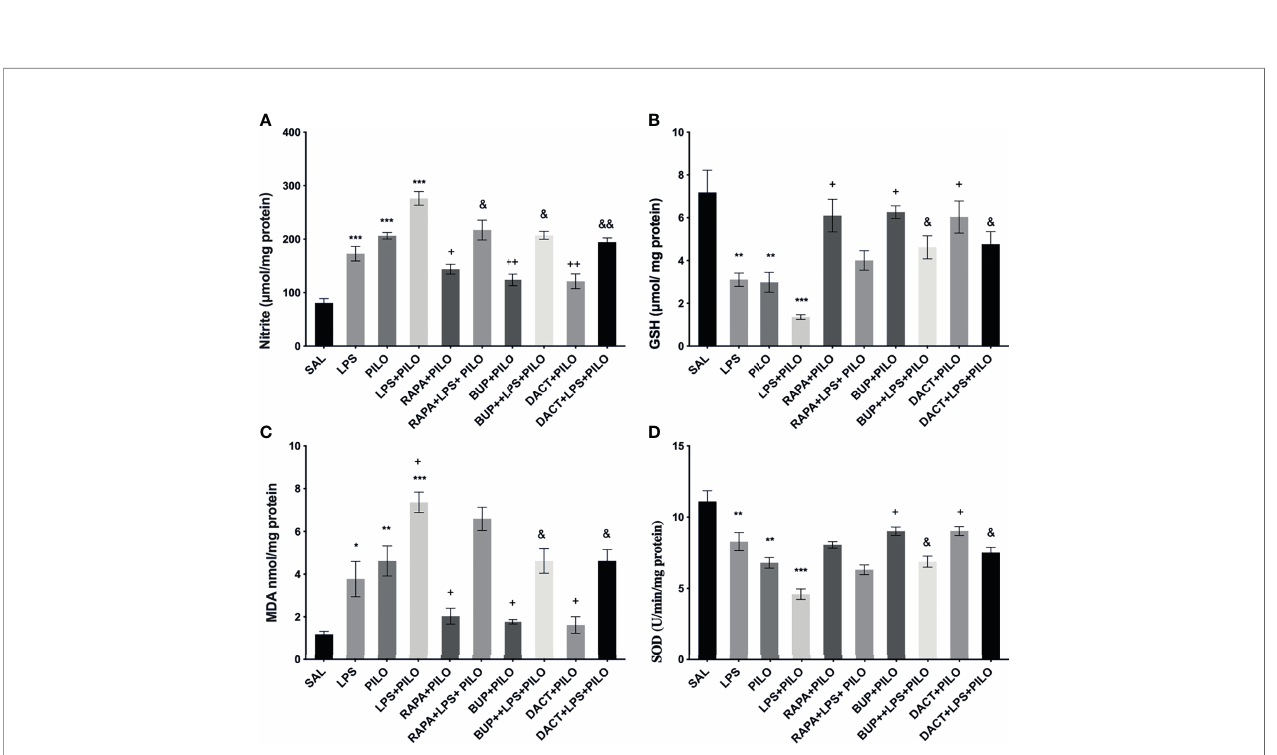
FIGURE 9 | Effects of RAPA, BUP, and DACT on PILO versus LPS+PILO-induced on oxidative stress levels in C57BL/6 mice. (A) Nitrite, (B) GSH, (C) MDA, and (D) SOD levels. Data are represented as mean ± SEM (n=3) and analyzed by Tukey Kramer multiple comparison tests. The signi fi cance is ascertained as ***p < 0.001 versus SAL, **p < 0.01 versus SAL, *p < 0.05 versus SAL, ++ p < 0.01 versus PILO, + p < 0.05 versus PILO, && p < 0.01 versus LPS+PILO, and & p < 0.05 versus